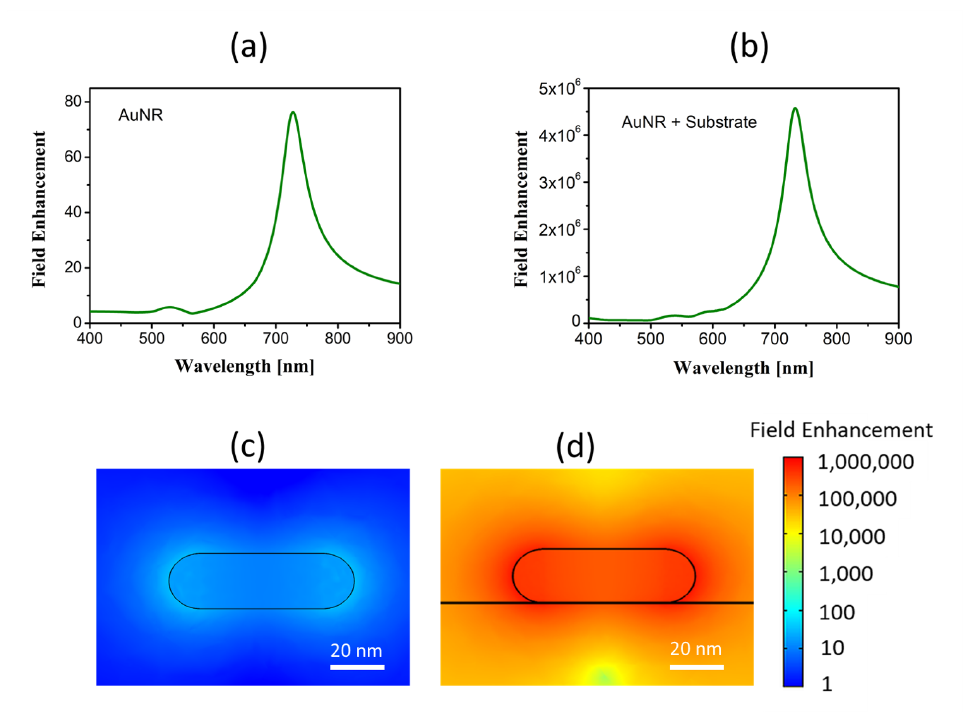
Figure 5. Maximum field enhancement as a function of wavelength for the case of ( a ) the nanorods immersed in water and ( b ) deposited on a Si substrate. Spatial maps of the electric field in a plane perpendicular that contains the axis of the nanorod at λ = 728 nm for the case of ( c ) the nanorods immersed in water and ( d ) deposited on a Si substrate. They are represented in log same